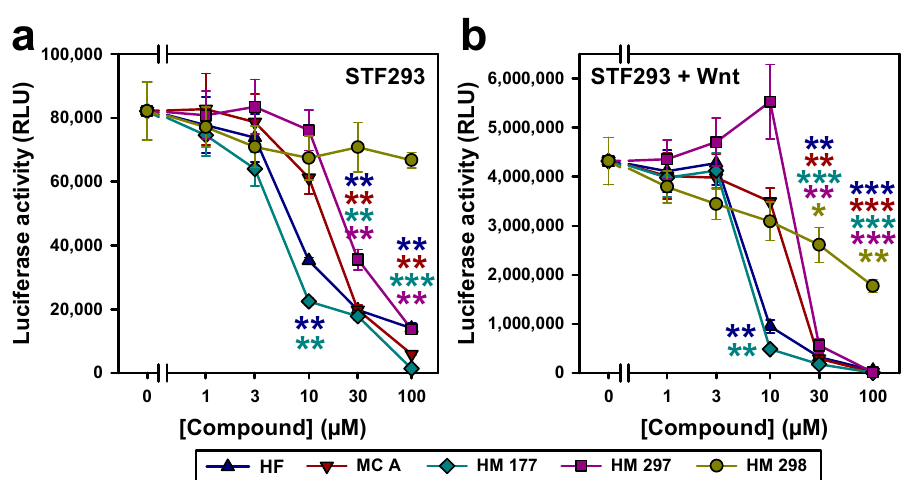
Figure 6. HF and MCs inhibit canonical Wnt signaling, as analyzed in reporter gene assays with ( a ) STF293 cells ( b ) or Wnt3a-conditioned-medium-treated STF293 cells. Relative luminescence units (RLU) were measured under identical conditions. The graph summarizes results of 3 independent experiments measured in duplicate. * p < 0.05; ** p < 0.01, *** p < 0.001 (two-tailed Student’s t -test). An inhibitory activity of HF and the MCs on the canonical Wnt pathway as detected in the reporter gene assays should also result in the down-regulation of endogenous Wnt target gene expression. Due to a stabilizing mutation in β -catenin, the canonical Wnt pathway in these cells is intrinsically activated. To evaluate this in more detail, quantitative RT-PCR was performed on RNA isolated from HCT116 cells to determine the expression of the well-known Wnt target genes Axin2 [42,43] and SP5 [44,45], encoding a component of the β -catenin destruction complex and a Zn finger transcription factor, respectively. HCT116 cells were treated with 3 μ M of compounds to avoid toxic side effects. HF and HM 177 induced a strong down-regulation of both target genes, whereas MC A and HM 297 showed weaker effects (Figure 7). Taken together, these data further point to a Wnt inhibitory effect of the compounds.